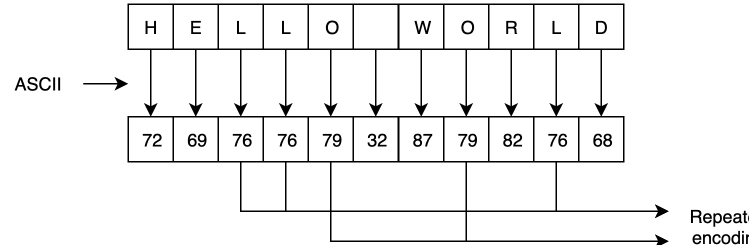
Figure 5. Repeated encoded characters using the ASCII table.